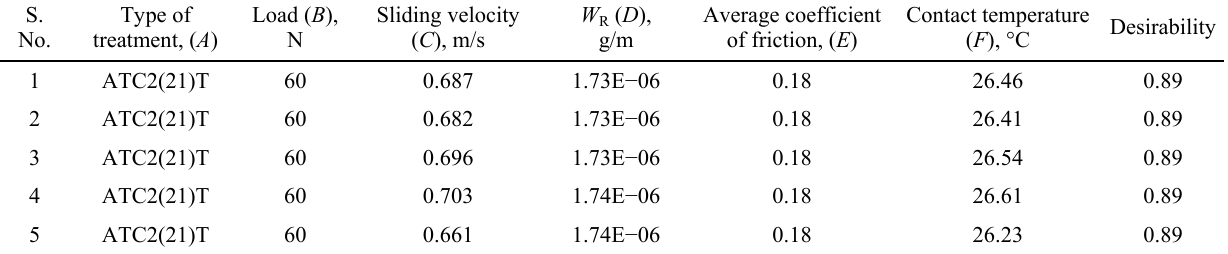
Table 16 Results of the conformity tests for the tribological parameters. Process